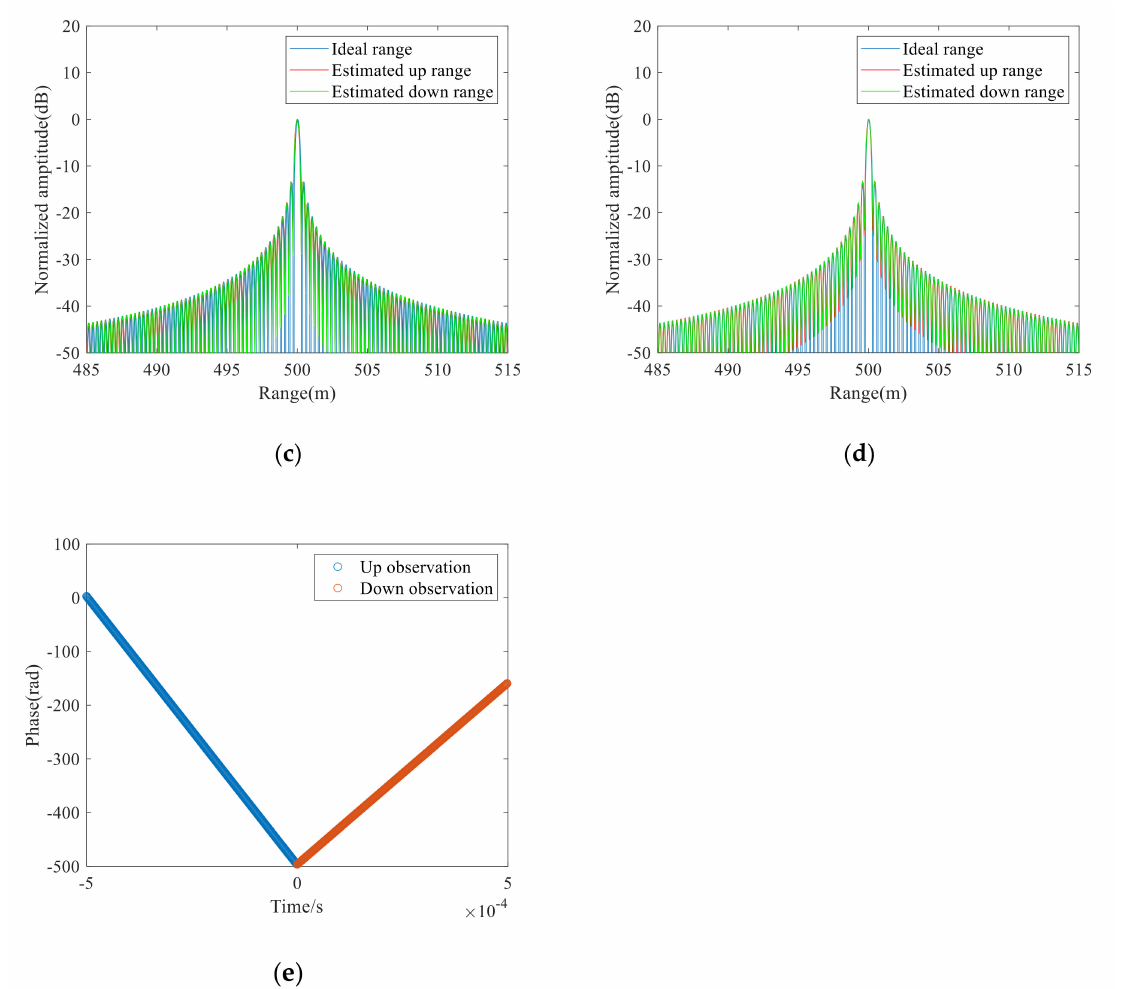
Figure 4. ( a ) Interference frequencies of the up and down observations; ( b ) One-dimensional range distributions after removing quadratic vibration errors; ( c ) One-dimensional range distributions after removing primary vibration errors by using the proposed method; ( d ) One-dimensional range distributions by using the Doppler frequency shift method; ( e ) Phase distributions in the up and down